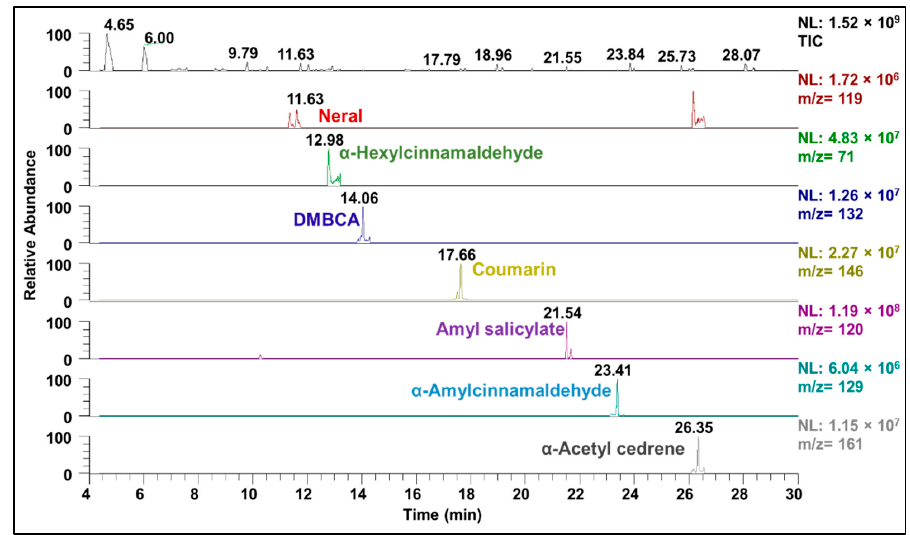
Figure 2. SIM-B chromatogram of the sample collected in the house.